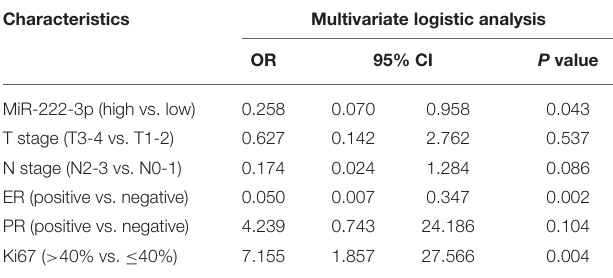
TABLE 2 | Multivariate logistic analysis for predictive factors of